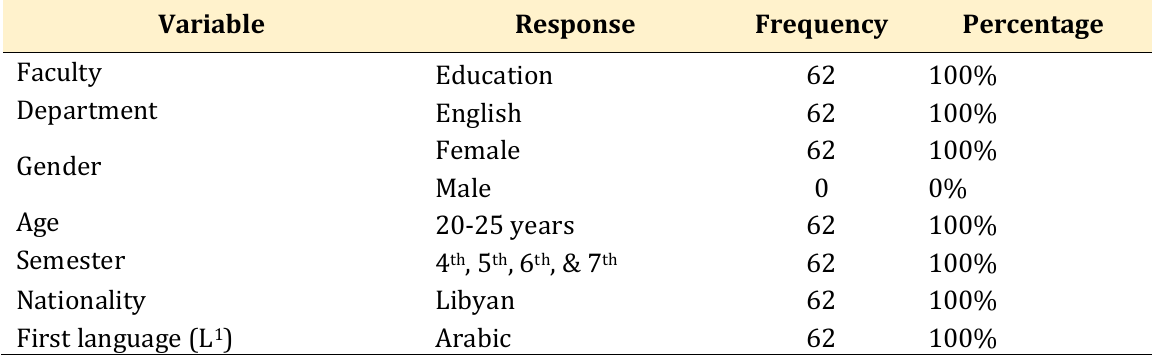
Table 1. Socio-demographic data of the study participants